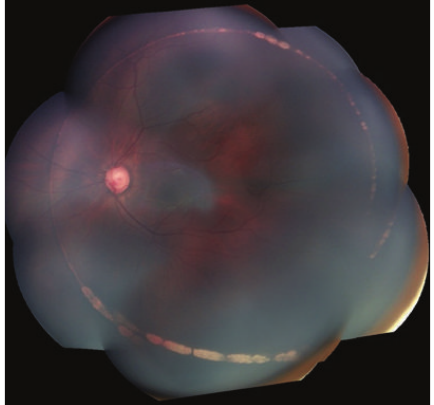
Figure 1: Color fundus photography demonstrating circumferential chorioretinal scarring after misdirection of blunted 6-0 polypropy- lene suture used in filament-assisted circumferential trabeculotomy (photograph courtesy of Ms. Ditte